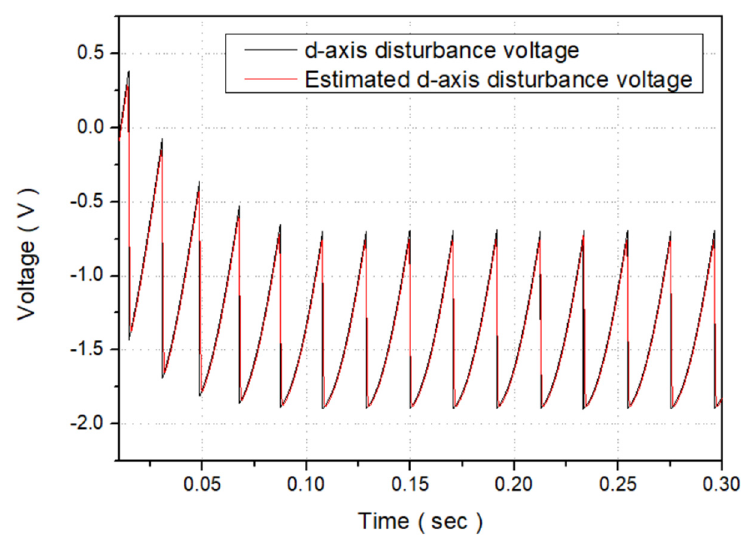
Figure 13. The actual disturbance voltage occurring on the d − axis during the dead time and the waveform of the d − axis disturbance compensation voltage estimated through the disturbance observer.